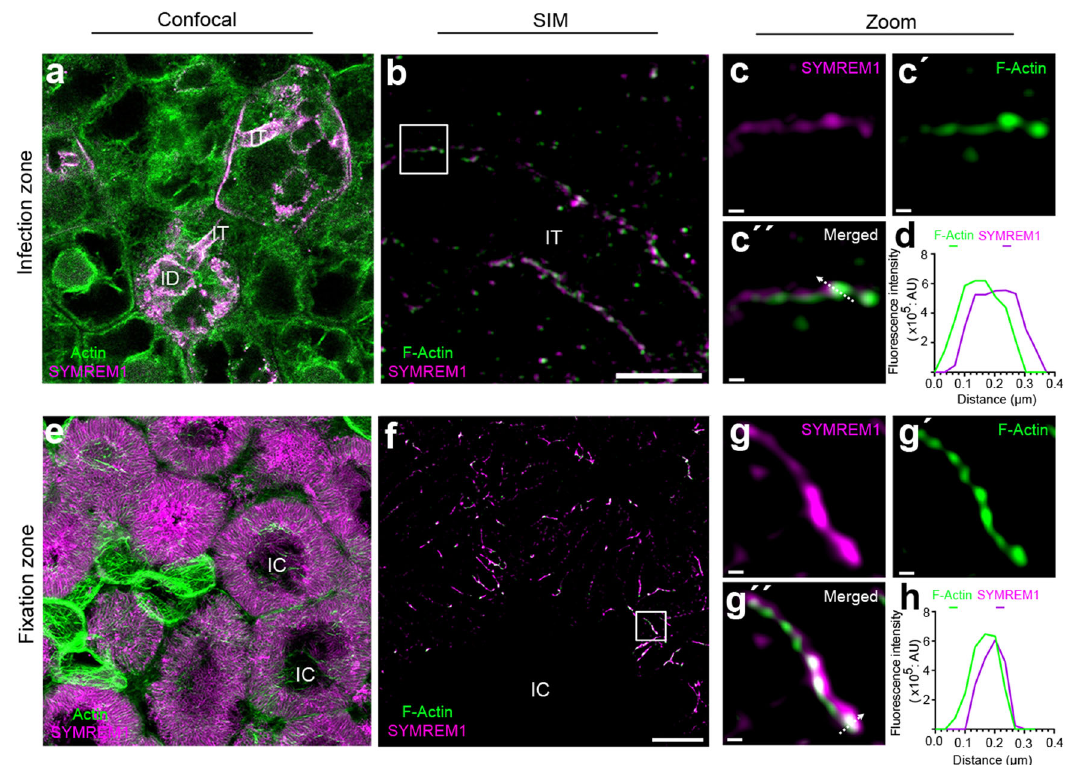
Fig. 6 | SYMREM1 and F-actin colocalize at infection structures inside nodules. Sections of two weeks old nodules from a stable transgenic Medicago truncatula plant expressing an ABD-mCherry actin reporter (green). a , e SYMREM1 was immunolabelled (magenta) using a speci fi c α -SYMREM1 antibody. Maximum intensity projection of an infection thread (IT) ( b ) and symbiosomes ( f ) immu- nolabelled for SYMREM1 (magenta), counterstained with Phalloidin (green) and imaged using super-resolution structured illumination microscopy (SIM). c – c ′′ , g – g ′′ Close-ups ofareasindicatedbywhite boxes in ( b , f ). d , h 2Dlinescans ofthe